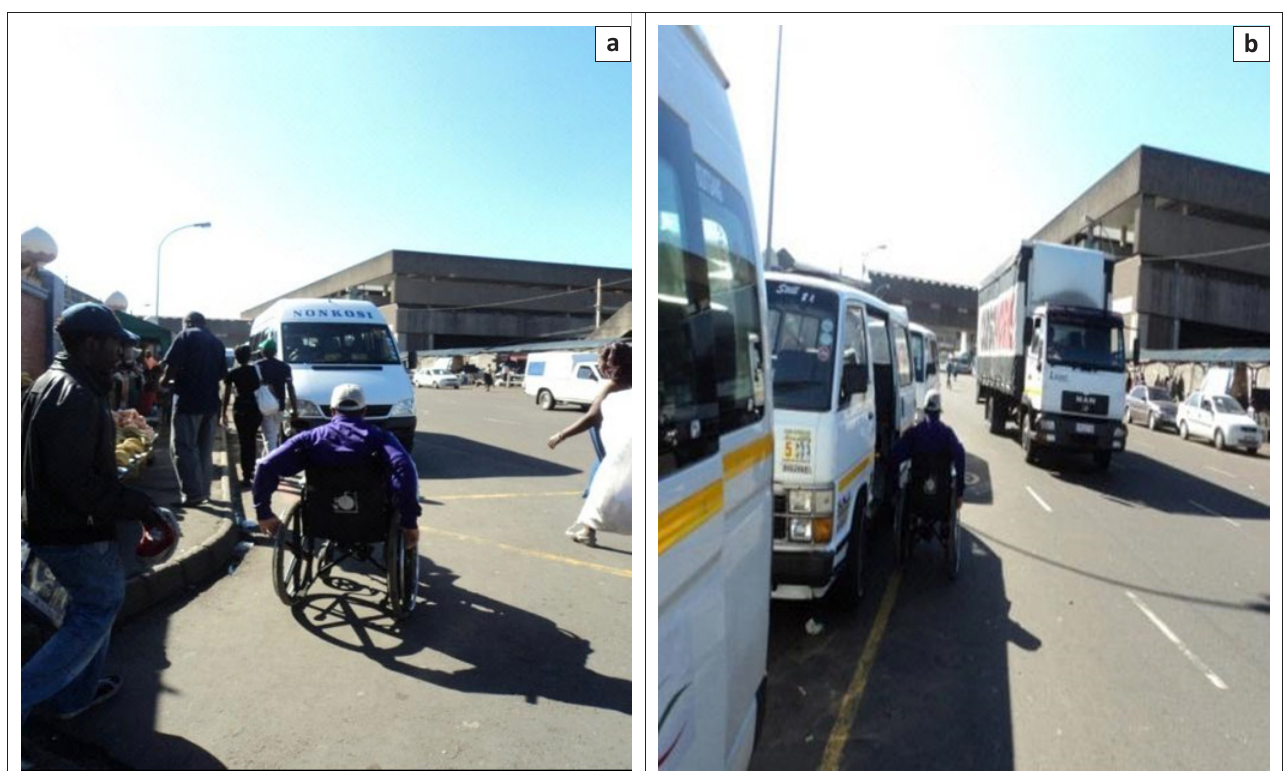
FIGURE 5: Wheelchair user accessing a taxi from the road.